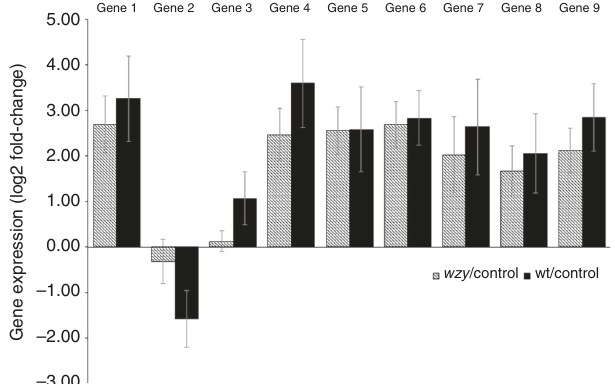
Fig. 4 Gene expression pro fi les of plants inoculated with puri fi ed LPSs from wild type or the wzy mutant. The bar plot depicts gene expression fold- changes (log2) when compared to diH 2 O control inoculations. RNAs from duplicate petioles were pooled to generate cDNA, and the experiment was repeated twice. Genes 1 – 9 correspond to: VIT_11s0052g01780 (1-deoxy- D - xylulose-5-phosphate synthase), VIT_00s0253g00040 (monocopper oxidase), VIT_08s0040g02200 (peroxidase ATP2a), VIT_01s0127g00400 (polygalacturonase), VIT_14s0060g00480 (S-adenosylmethionine synthetase 1), VIT_13s0067g02360 (peroxidase, class III), VIT_11s0052g01650 (pathogenesis-related protein 1 precursor), VIT_04s0008g00420 (clavata1 receptor kinase), and VIT_11s0052g01150 (nicotianamine synthase), respectively. Error bars represent the mean ± standard error of four pairwise comparisons (each of the two inoculated samples were compared to each of the two control